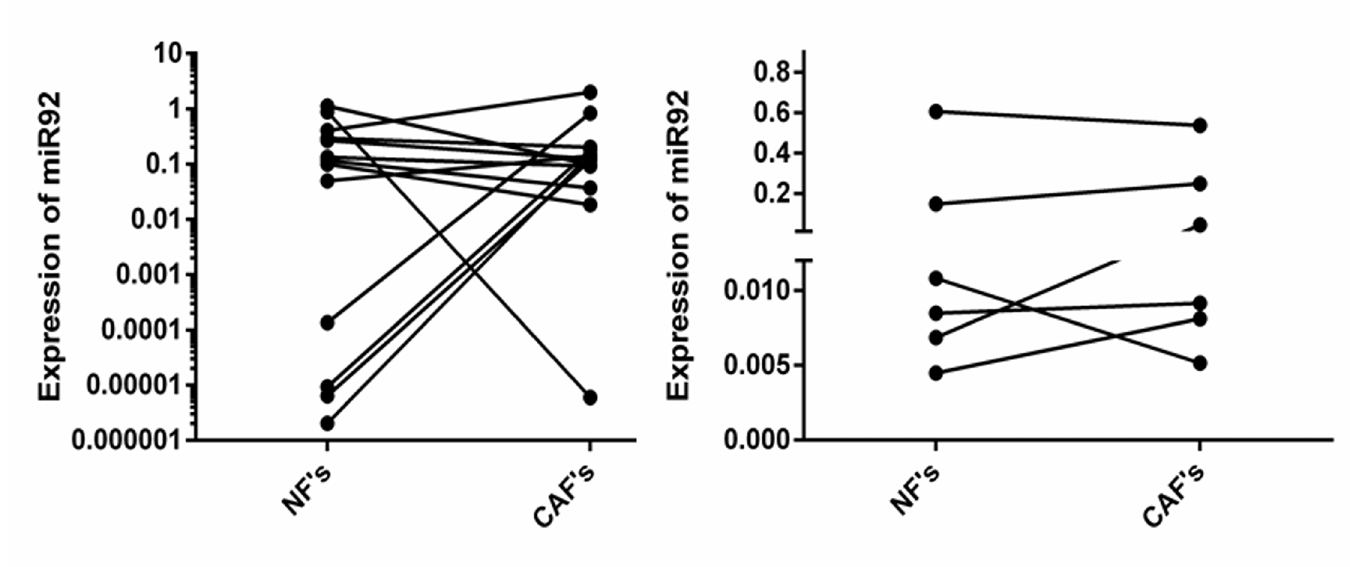
Fig 4. Expression of miR92 in normal fibroblasts (NFs) and cancer associated fibroblasts (CAFs) in patient samples (A) and primary fibroblast cultures (B) by qRT-PCR. * denotes significance of p = 0.0014 between NFs (high and low expressing groups) and NFs and CAFs (ANOVA).